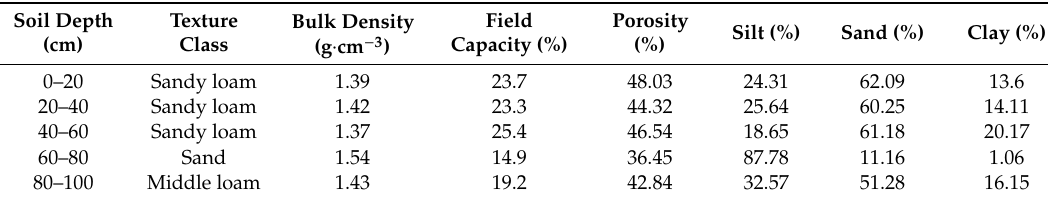
Table 2. Soil physical characteristics in the experimental area.